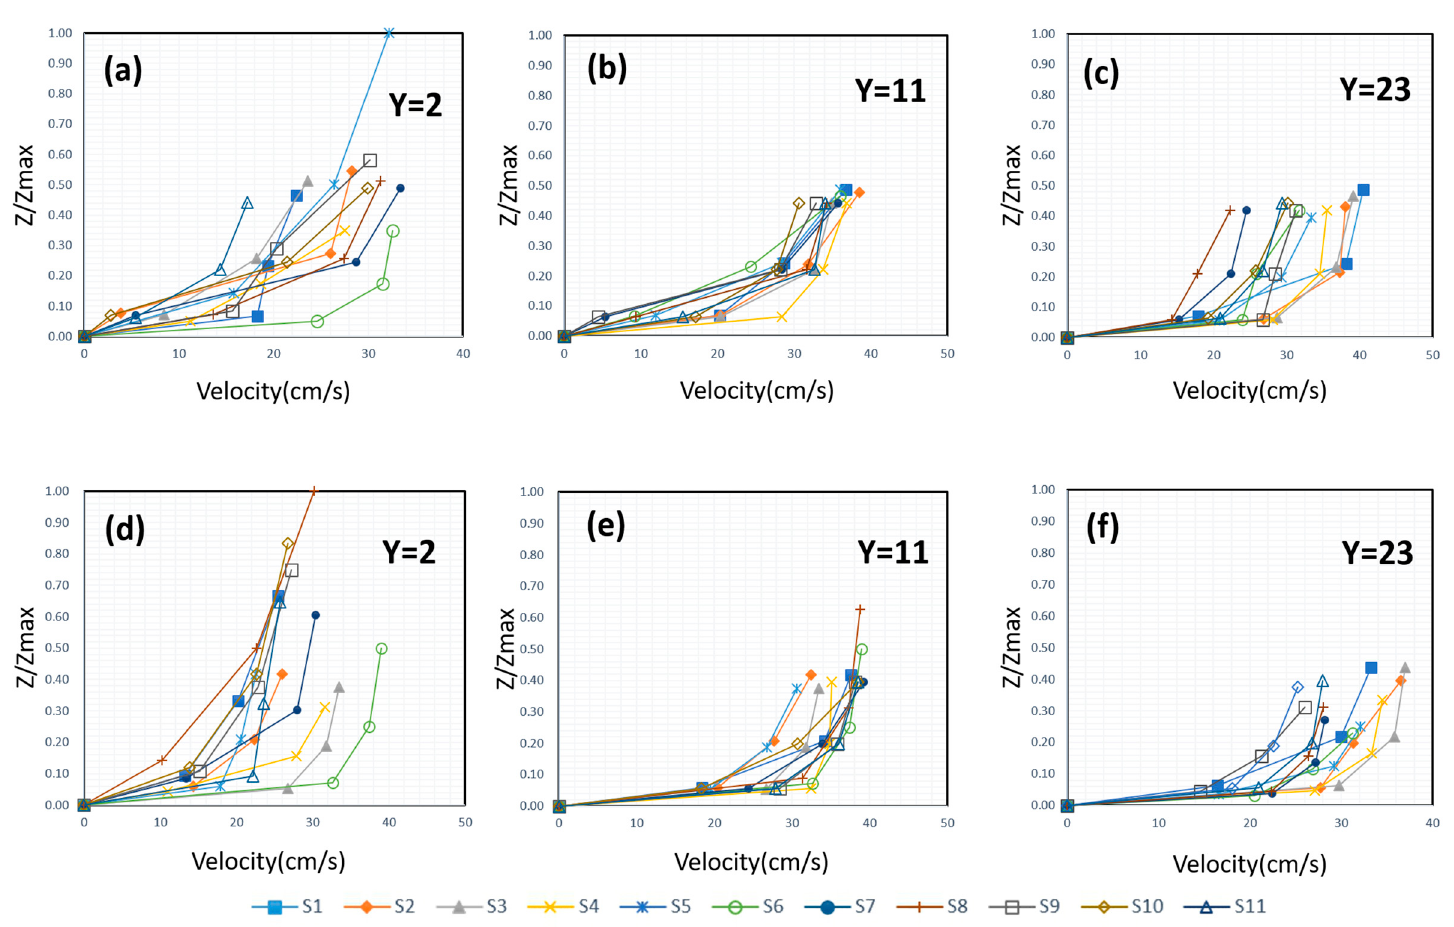
Figure 9. The sectional vertical velocity and its dimensionless scouring on 1 / 30 slope spur on flood recurrence interval of ( a – c ) for 10 years flood return period, and ( d – f ) for 20 years flood return period.